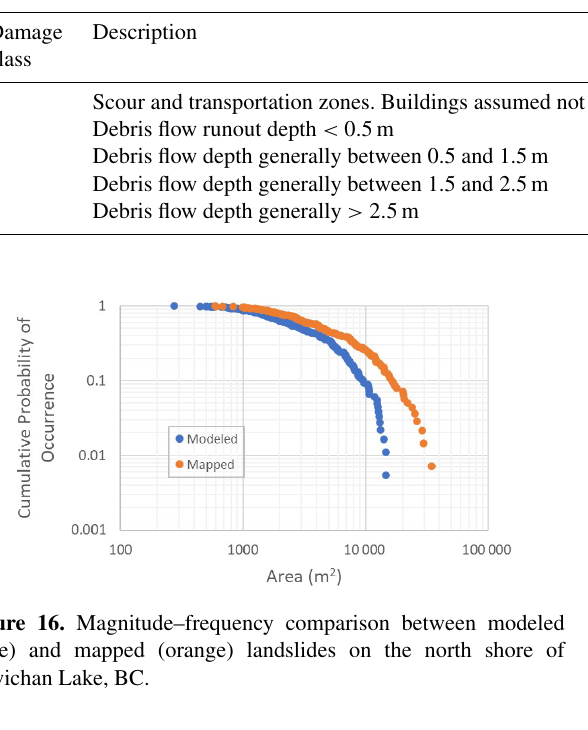
Table 5. Assigned debris flow damage classes.